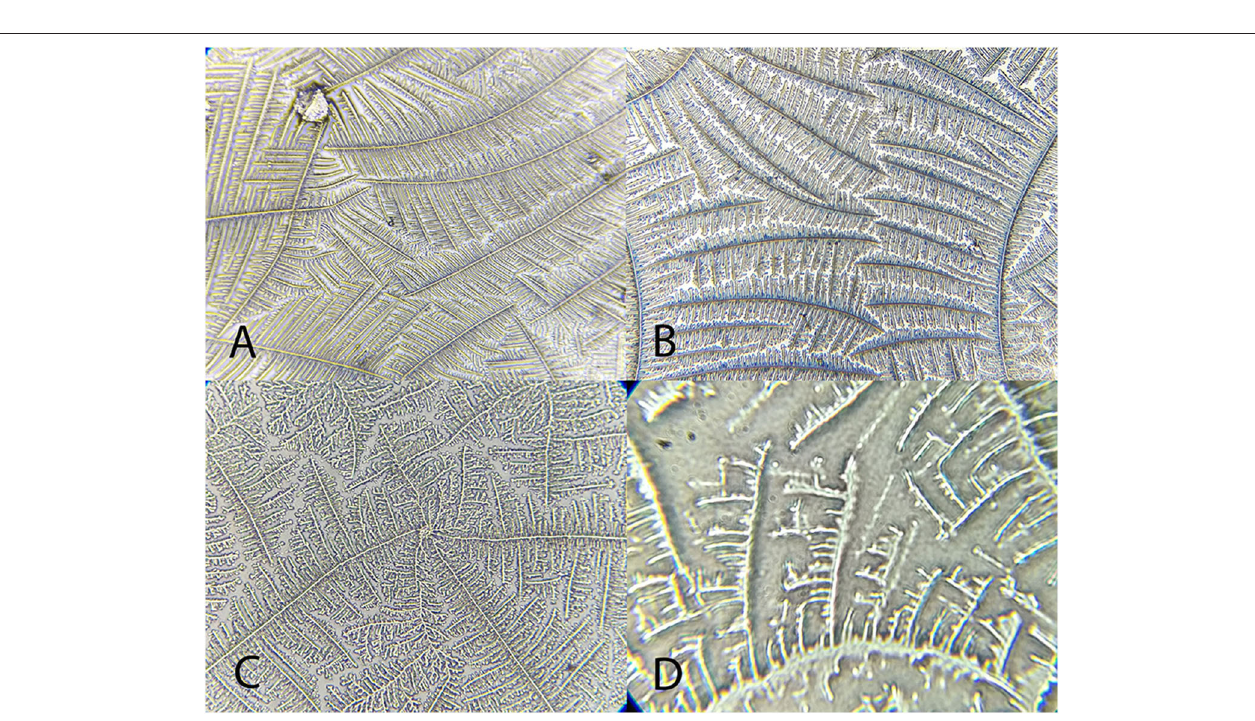
FIGURE 6 | Examples of Amazona aestiva tear ferning patterns, according to the Rolando and Masmali grading scales. (A) Type I (Rolando scale); (B) Type II (Rolando scale), grading 2 (Masmali scale); (C) grading 2 (Masmali scale); (D) Type III (Rolando scale), grading 3 (Masmali scale).